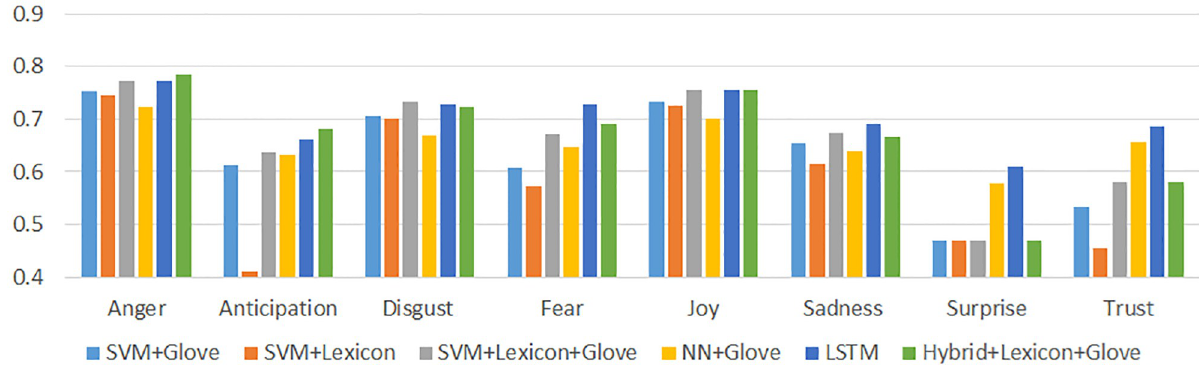
Fig 1. 10-fold cross validation F-score of the six different classifiers for the eight basic emotion types.